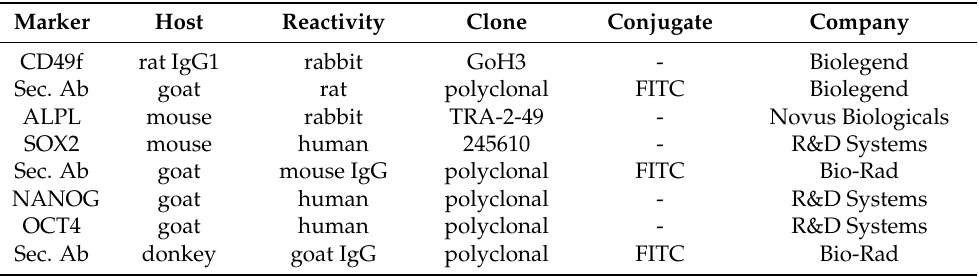
Table 2. List of additional primary and secondary antibodies used for confocal microscopy.